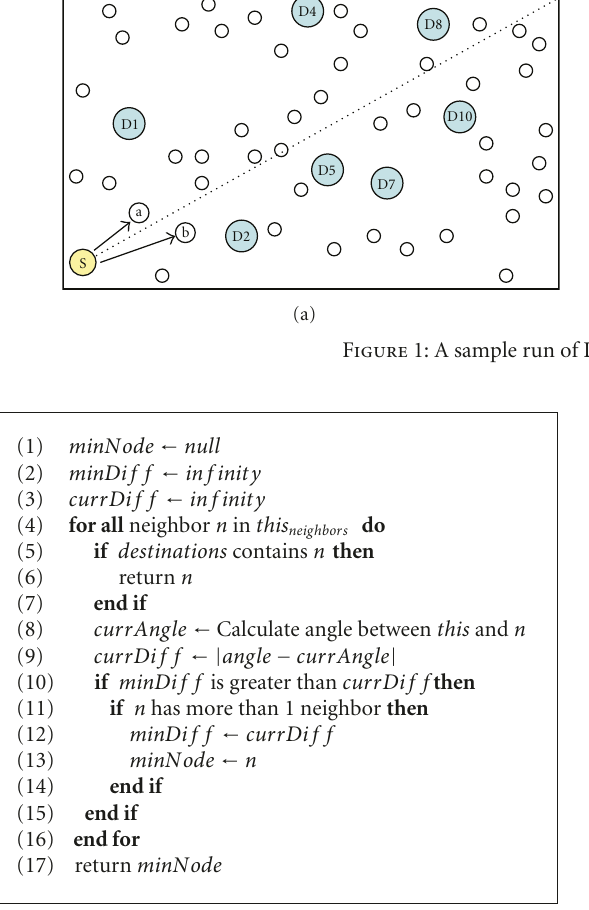
Algorithm 6: Selecting Next Neighbor in